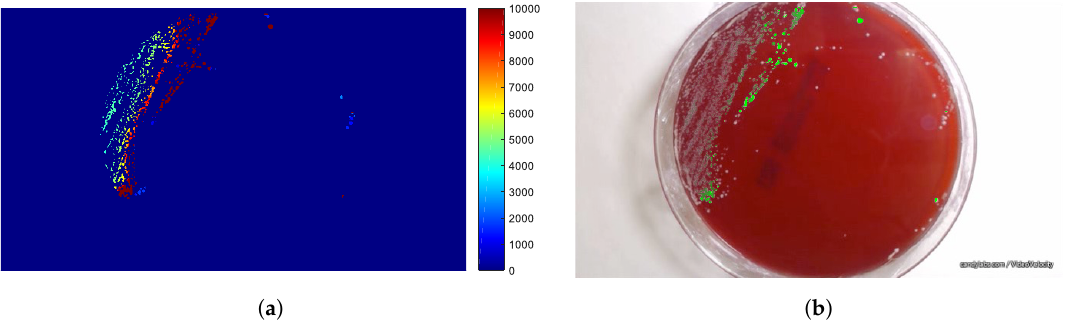
Figure 13. The pixels with observed zero growth rate during the experiment, shown in green, superimposed on the final frame of the petri dish.